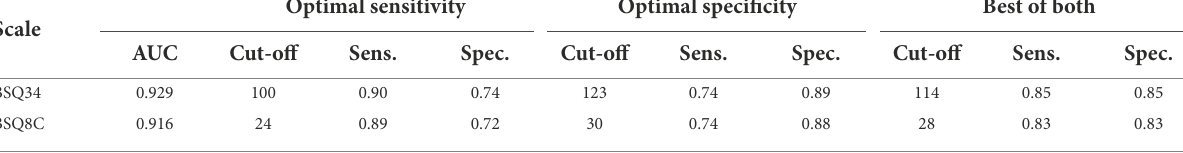
TABLE 3 Sensitivity and specificity for the Saudi-Arabic body shape questionnaire.